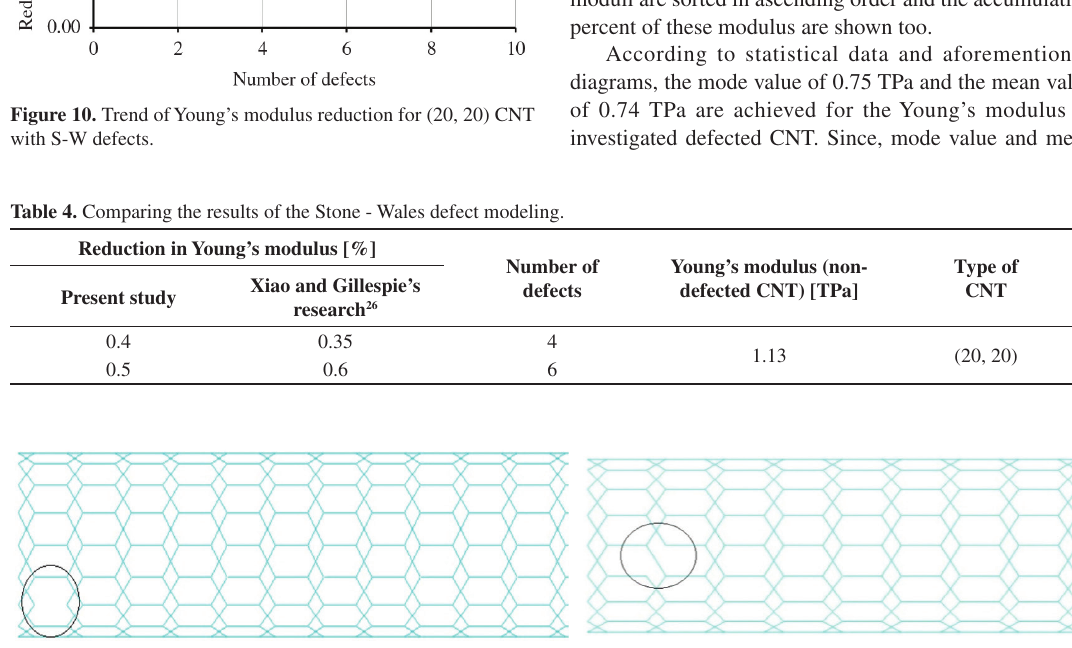
Figure 11. The position of a broken covalent bond in (9, 0) CNT leading to the highest reduction (right) and the lowest reduction (left) in CNT modulus.